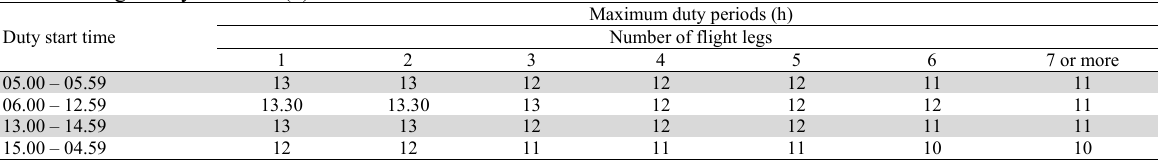
Maximum flight duty duration